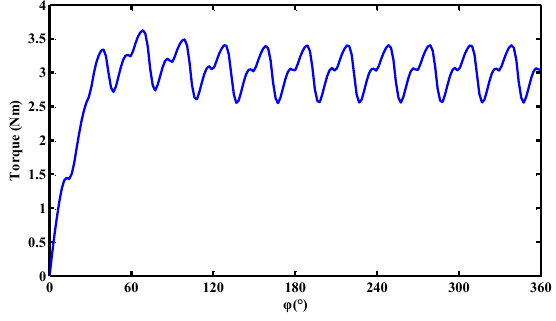
Figure 9. Transient rotation torque.